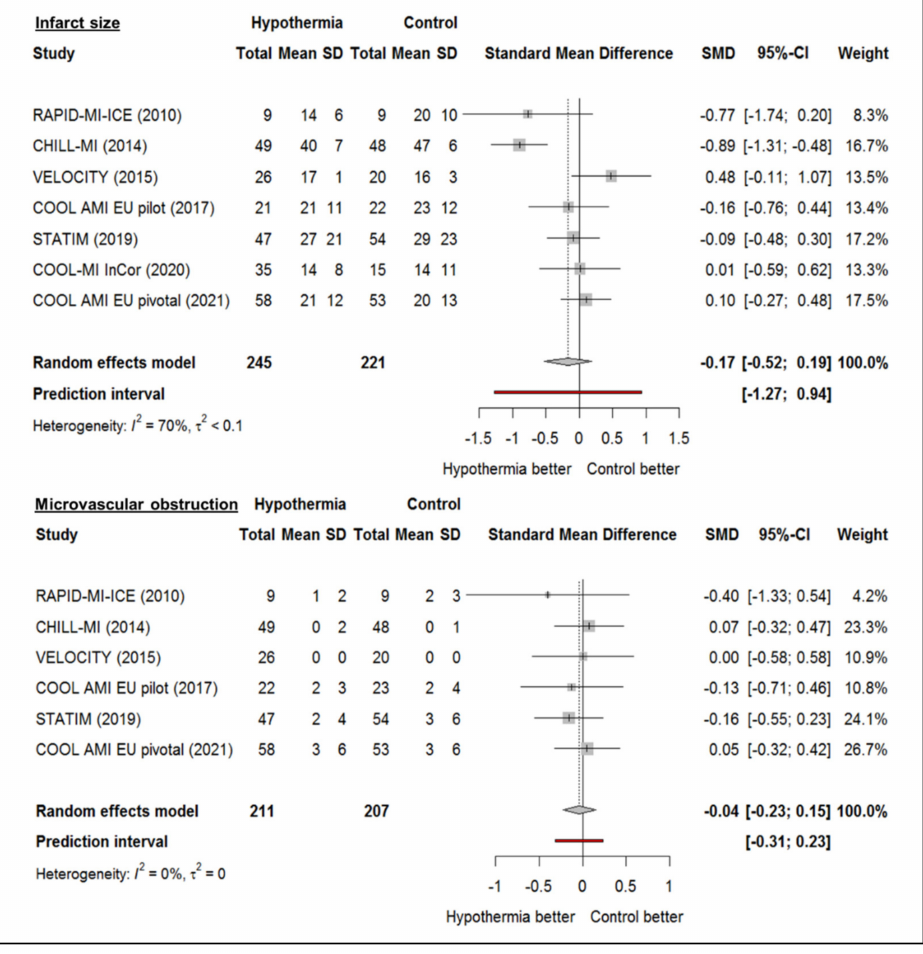
Figure 1. Study-level meta-analysis of randomized trials investigating systemic hypothermia for cardioprotection in STEMI and effect on infarct size and microvascular obstruction [26–32].